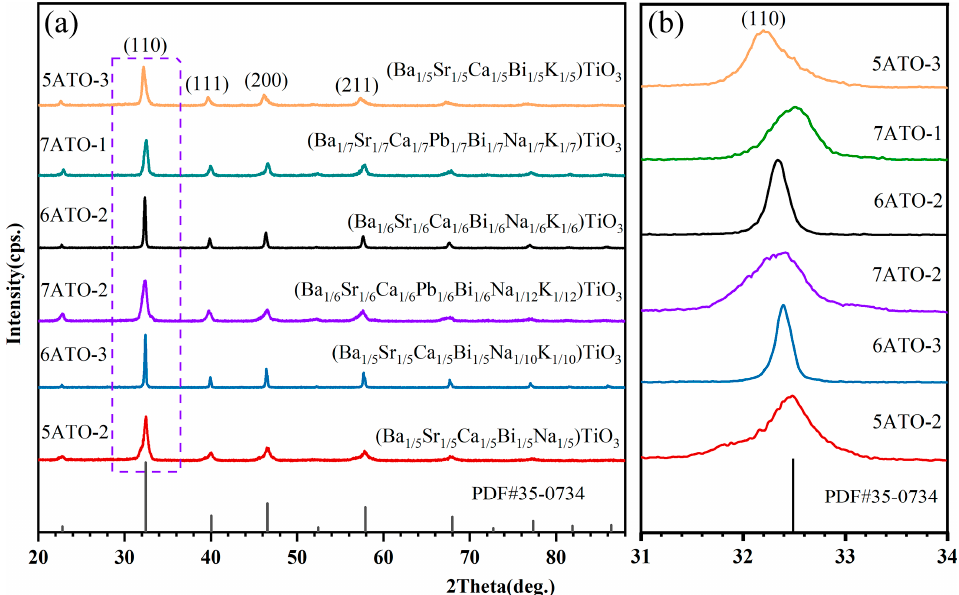
Figure 4. ( a ) XRD patterns of cubic perovskite oxides, ( b ) Zoom in view of the XRD patterns between 31° and 34°.